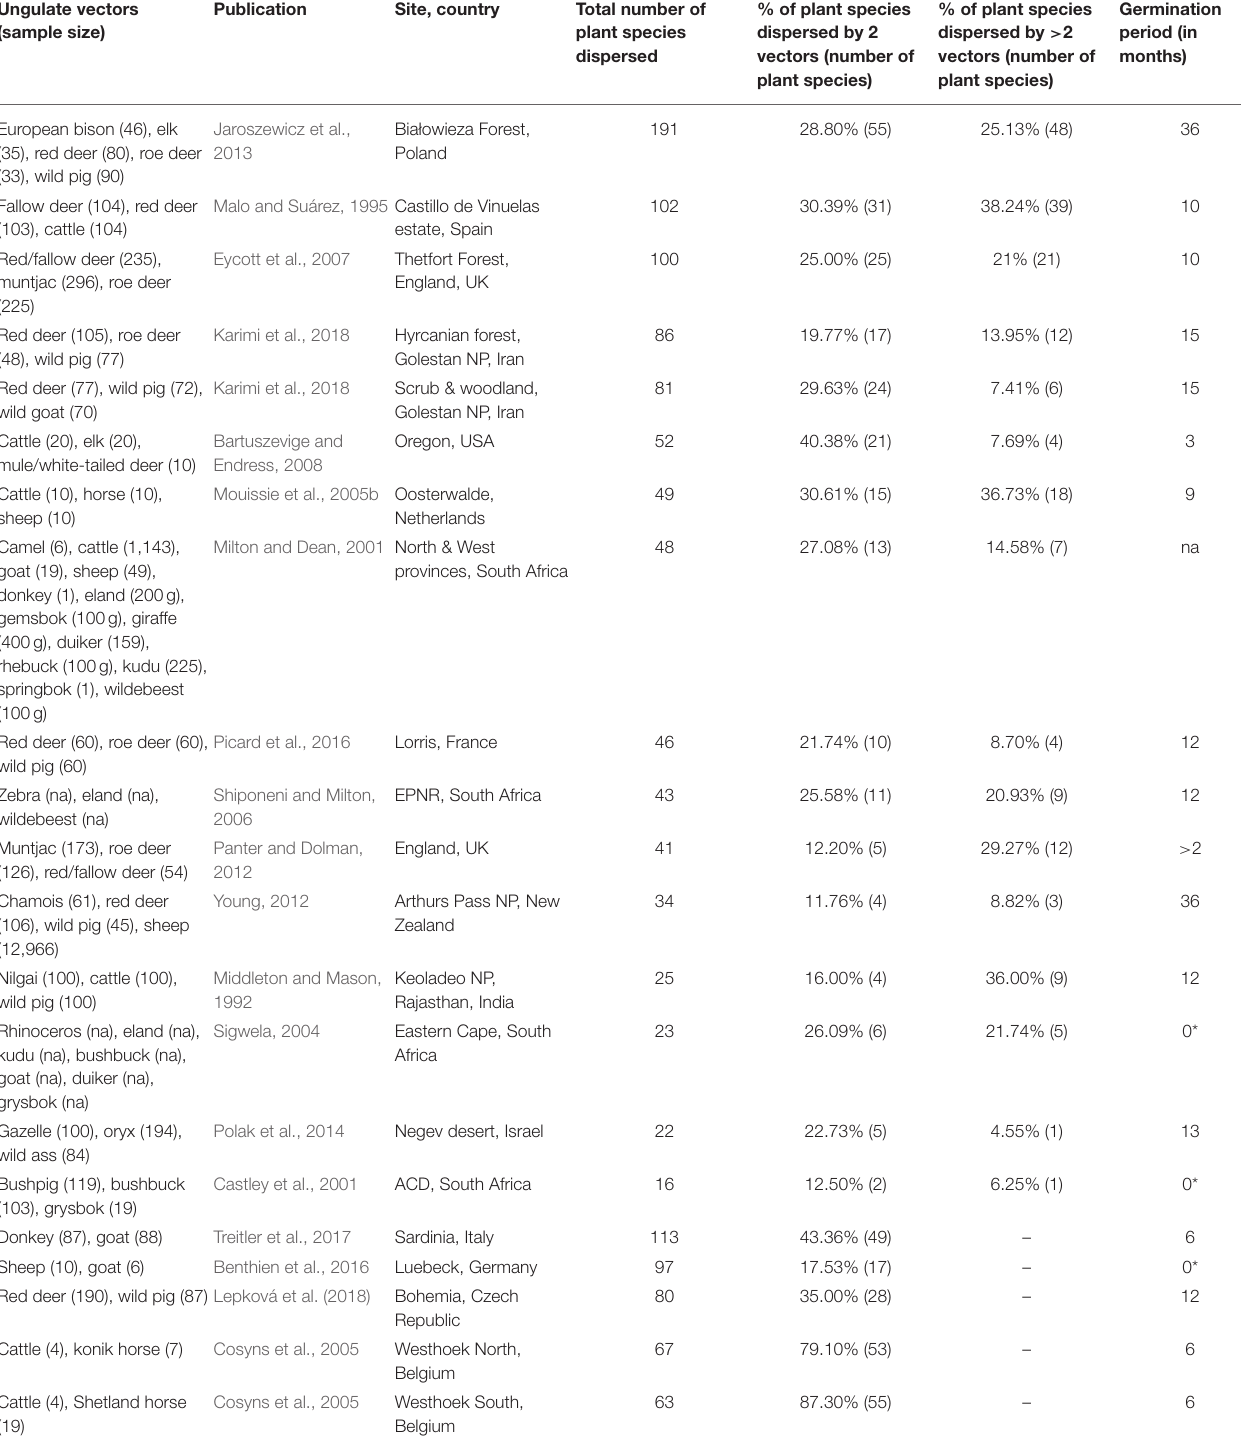
TABLE 3 | Studies on ungulate endozoochory included in the overlap and complementarity of ungulate-mediated plant dispersal: ungulate sample size (given as weight in grams or as number of fecal samples), publication, location (site, country), total number of plant species dispersed, % of plant species dispersed by 2 vectors or more, and germination period ( * indicates studies where diaspores were identified under a magnifying glass and not after seedling emergence). Ungulate vectors (sample